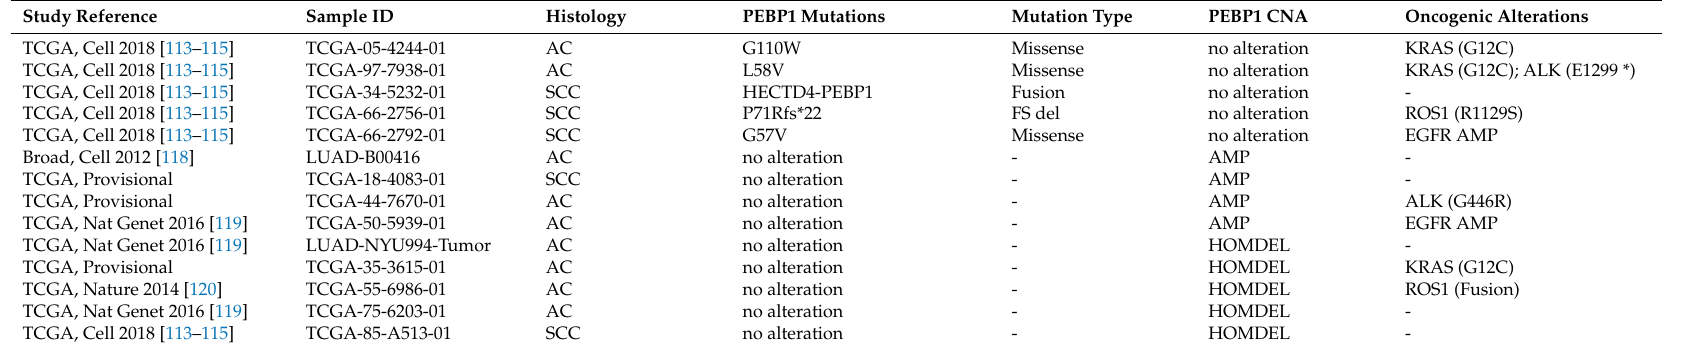
Table 3. Genomic alterations on PEBP1 gene in lung cancer (TCGA data)